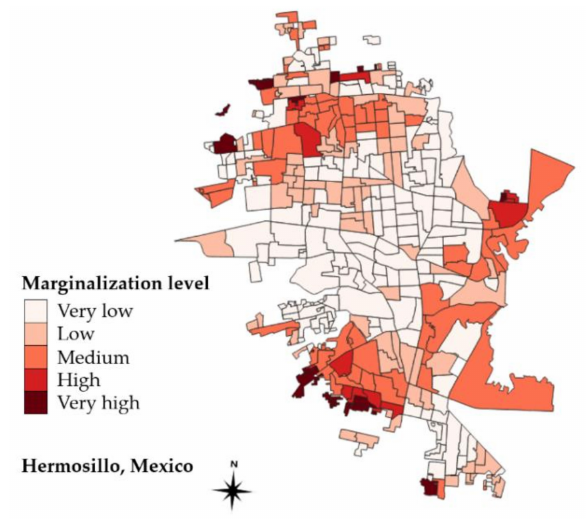
Figure 4. Basic geo-statistical areas by social marginalization level in Hermosillo City ( n = 410 AGEB).